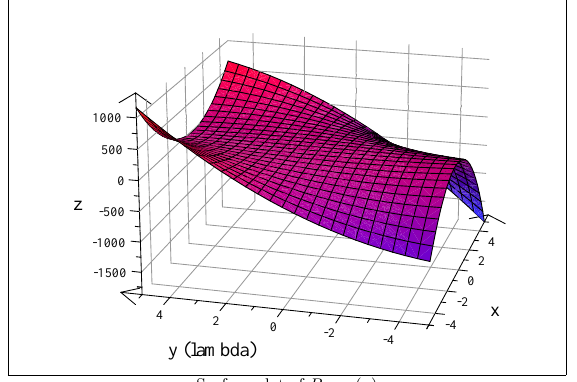
Figure 3. Surface plot of B 1,4; λ ( x ) .